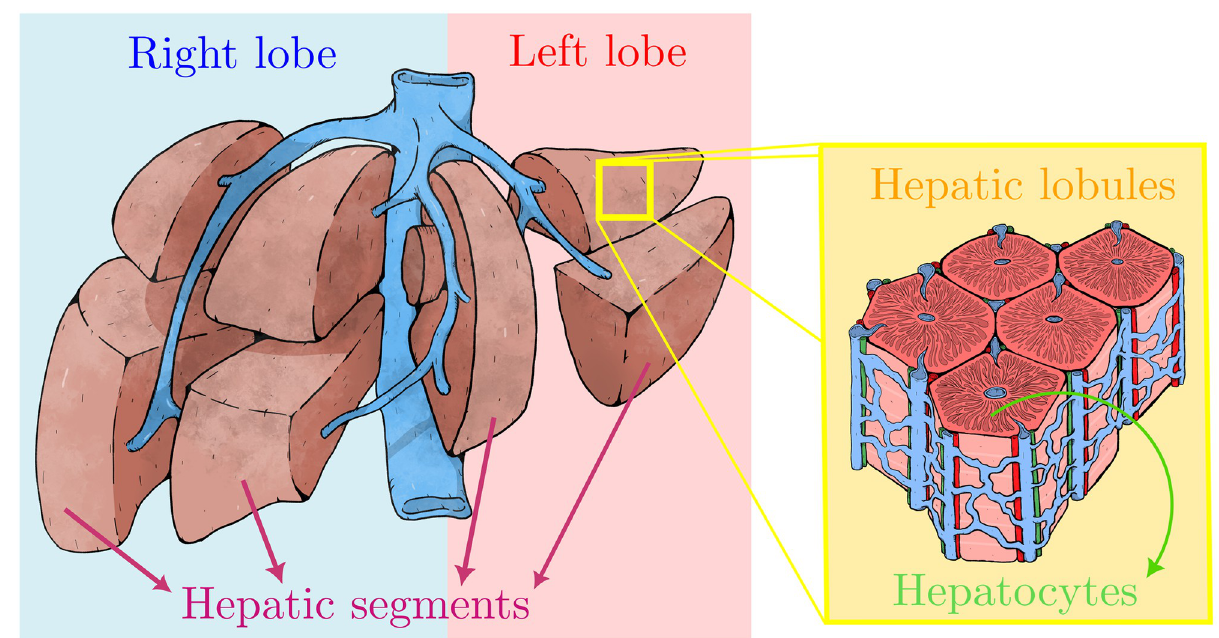
Fig 1. Schematic representation of the multi-scale liver architecture. The human liver is divided grossly into four parts or lobes. The four lobes are the right lobe, the left lobe, the caudate lobe, and the quadrate lobe. Seen from the front the liver is divided into two lobes: the right lobe and the left lobe. It is further divided in eight functionally independent segments based in the the Couinaud classification of liver anatomy. At the microscopic (histological) scale, the liver is organized in repetitive functional units called liver lobules, which take the shape of polygonal prisms (typically hexagonal in cross section). Each lobule is mainly constituted by hepatocytes and it is centered on a branch of the hepatic vein called the central vein which is interconnected with the interlobular portal triads: the hepatic artery (red), the portal vein (blue), bile duct